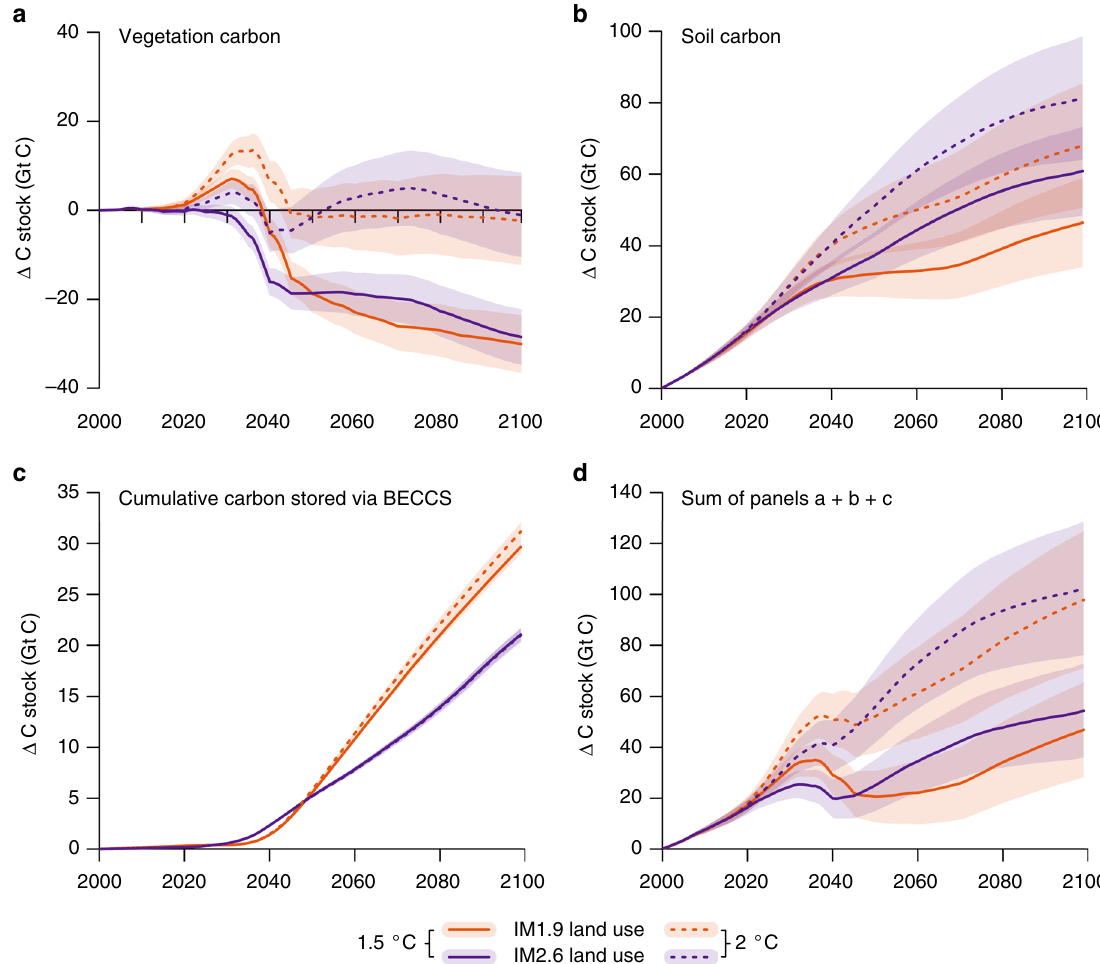
Fig. 2 Carbon cycle responses to two land-use and two climate stabilization scenarios simulated by the land surface model JULES. Land-use scenarios are shown with different colours: IM1.9 (orange) and IM2.6 (purple), and the climate scenarios are shown with different line patterns: 1.5 °C (solid) and 2 °C (dashed) above preindustrial by 2100. Panels show simulated vegetation ( a ) and soil carbon ( b ), the cumulative storage of carbon through BECCS ( c ), and the total land carbon stock (including captured carbon via BECCS) ( d ). Shading shows ± 1 standard deviation from the ensemble mean from the 34 ESM climates represented in